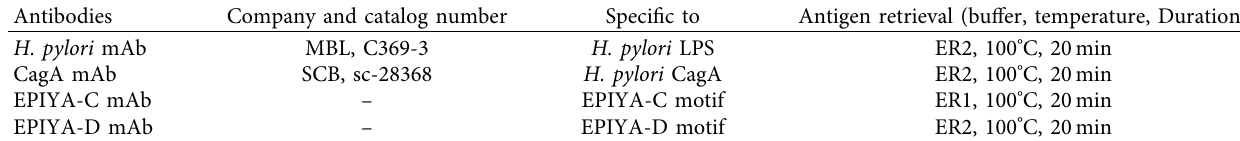
Table 1: Monoclonal antibodies and antigen retrieval protocol used for the Leica IHC detection system.